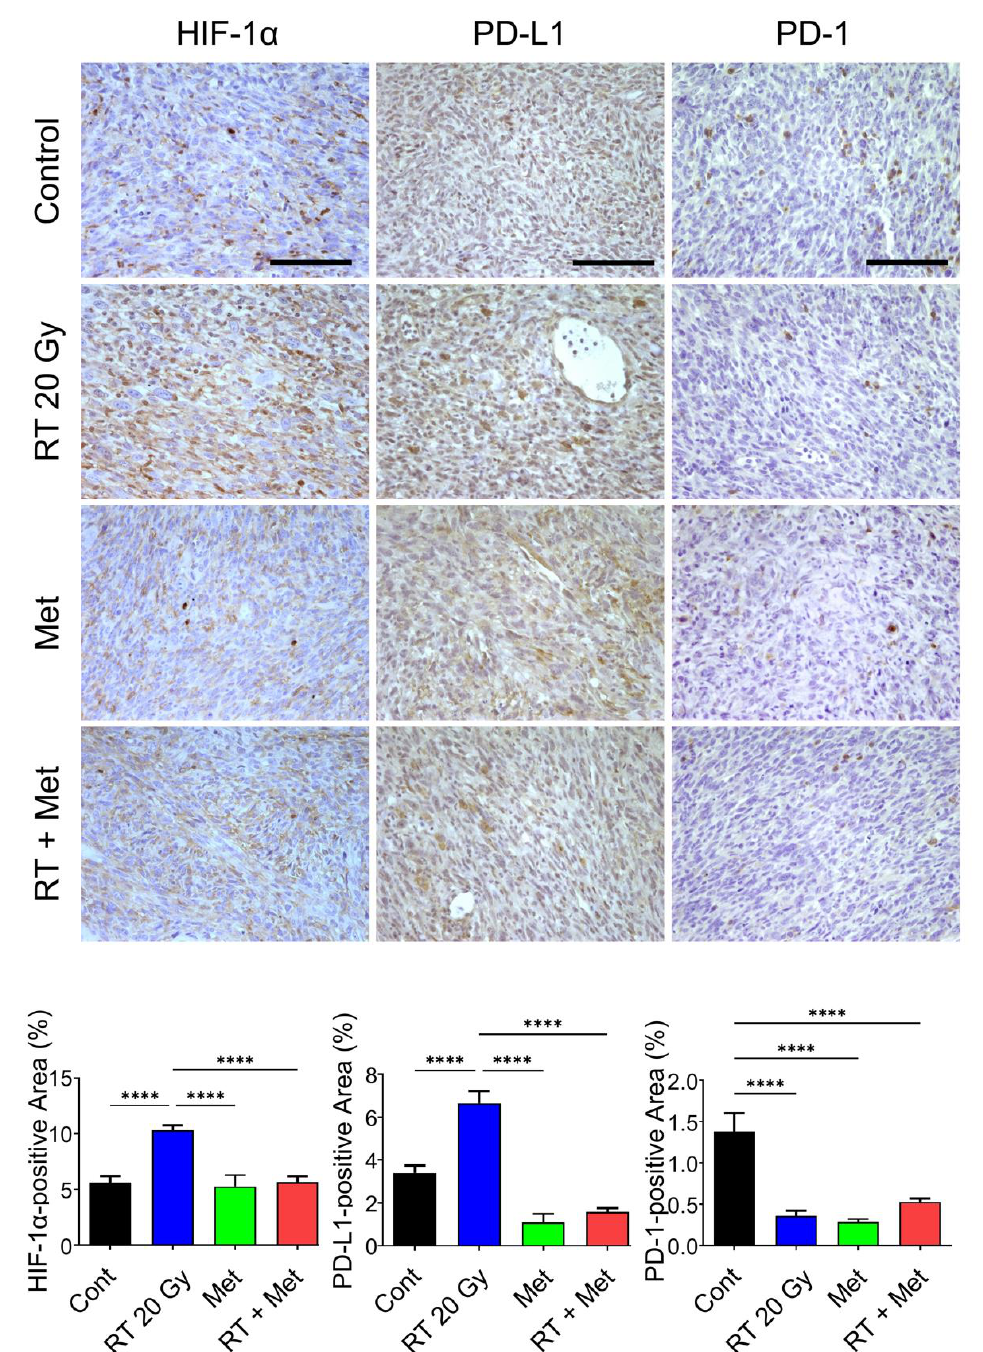
Figure 4. Immunohistochemical protein expression of HIF-1α, PD-L1, and PD-1 in FSaII tumors on day 3 after 20 Gy irradiation. Irradiation markedly increased HIF-1α and daily administration of metformin (150 mg/kg/day) abrogated the radiation-induced increase in HIF-1α. The PD-1 level decreased by irradiation was probably due to death of T-cells expressing PD-1. At least five images per section were captured and the percentage of positive areas was calculated with Image J. The means of tumors ± SD are shown. The scale bars represent 100 μm. ****, p < 0.0001, one-way ANOVA.